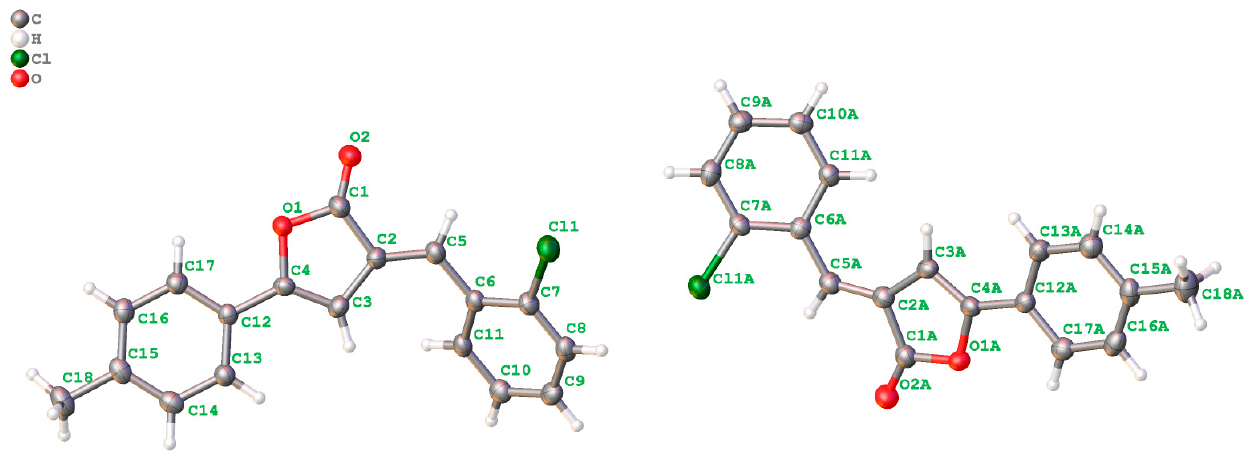
Figure 2. The geometry of the two crystallographically independent forms of ( 1 ) in the asymmetric unit. Displacement ellipsoids are drawn at the 50% probability level.